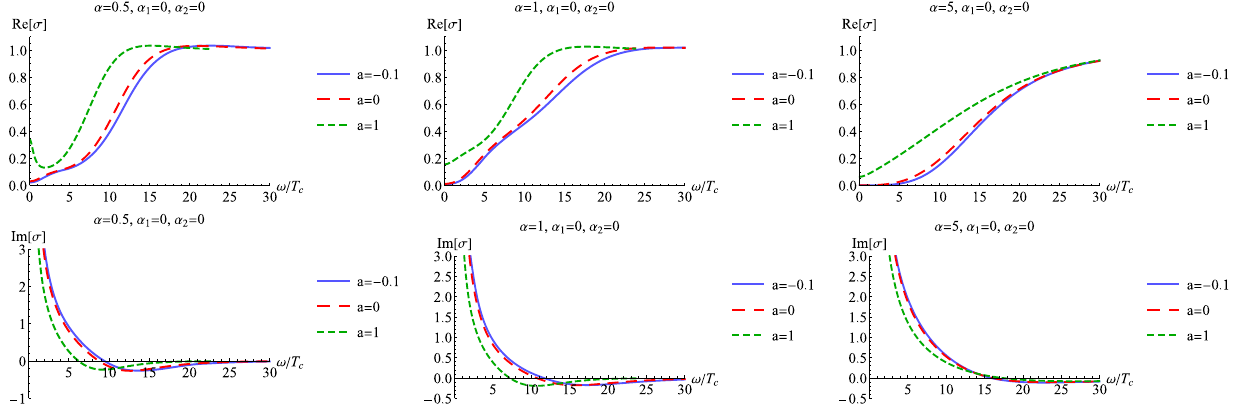
Fig. 7 The behavior of conductivity with varying a for different α in the superconducting state. Here we fix the temperature T / T c ≈ 0 . 2. Here we have abbreviated the two dimensionless quantities { T /μ,α/μ } to { T ,α }